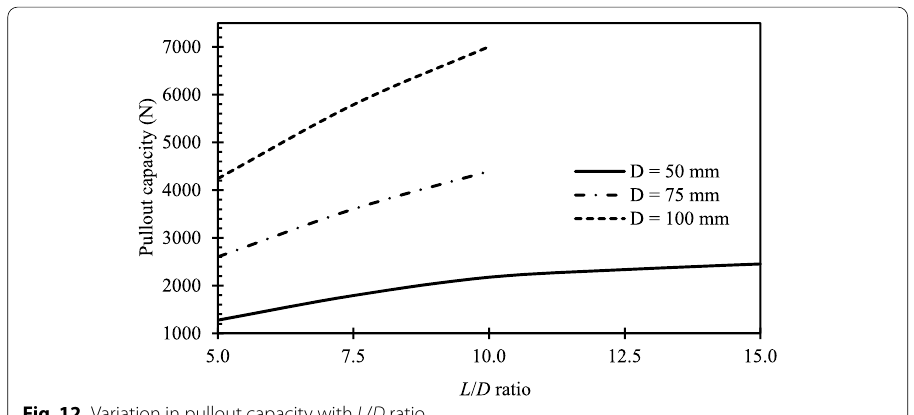
Fig. 12 Variation in pullout capacity with L / D ratio